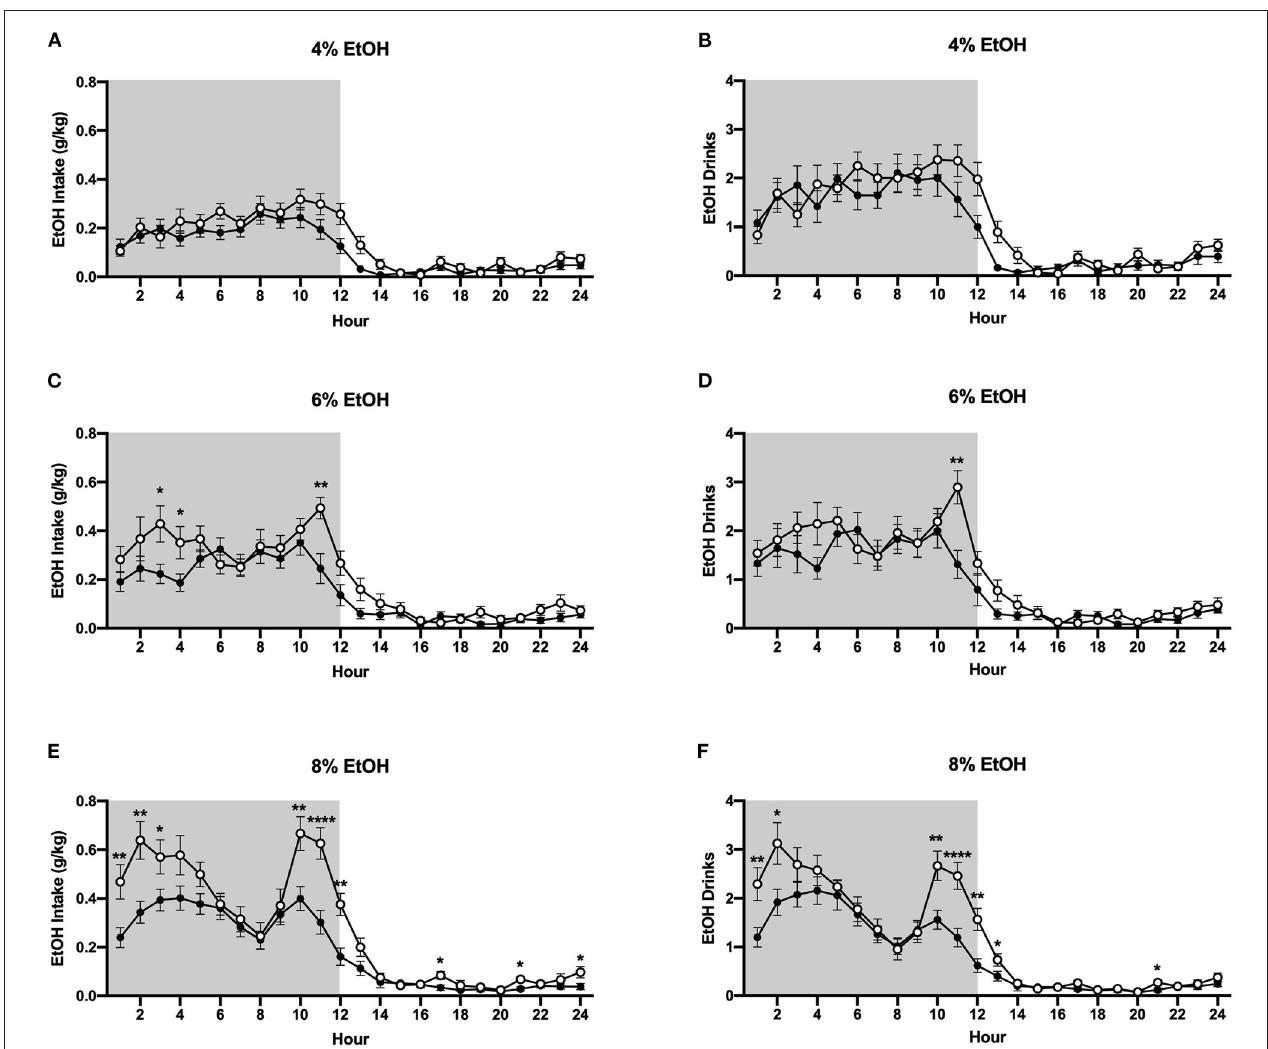
FIGURE 4 | Hourly baseline ethanol data. (A) Ethanol intake in g/kg for 4% ethanol. (B) Number of ethanol drinks for 4% ethanol. (C) Ethanol intake in g/kg for 6% ethanol. (D) Number of ethanol drinks for 6% ethanol. (E) Ethanol intake in g/kg for 8% ethanol. (F) Number of ethanol drinks for 8% ethanol. * p < 0.05, ** p < 0.01, **** p < 0.0001, compared to opposite housing condition. Socially-housed mice consumed significantly more g/kg ethanol and had more ethanol drinks than individually-housed mice at the 6% and 8% ethanol concentrations. Data represented as mean ± SEM. n = 24/group. Shaded regions are representative of the dark